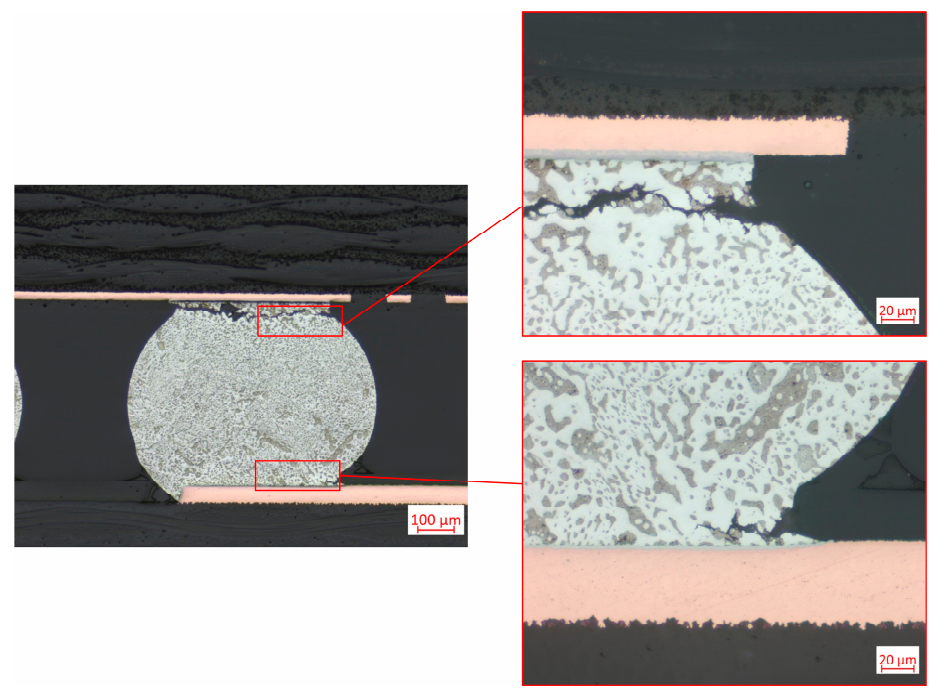
Figure 11. A SEM of failed solder joint for the temperature cycling tests in D101.